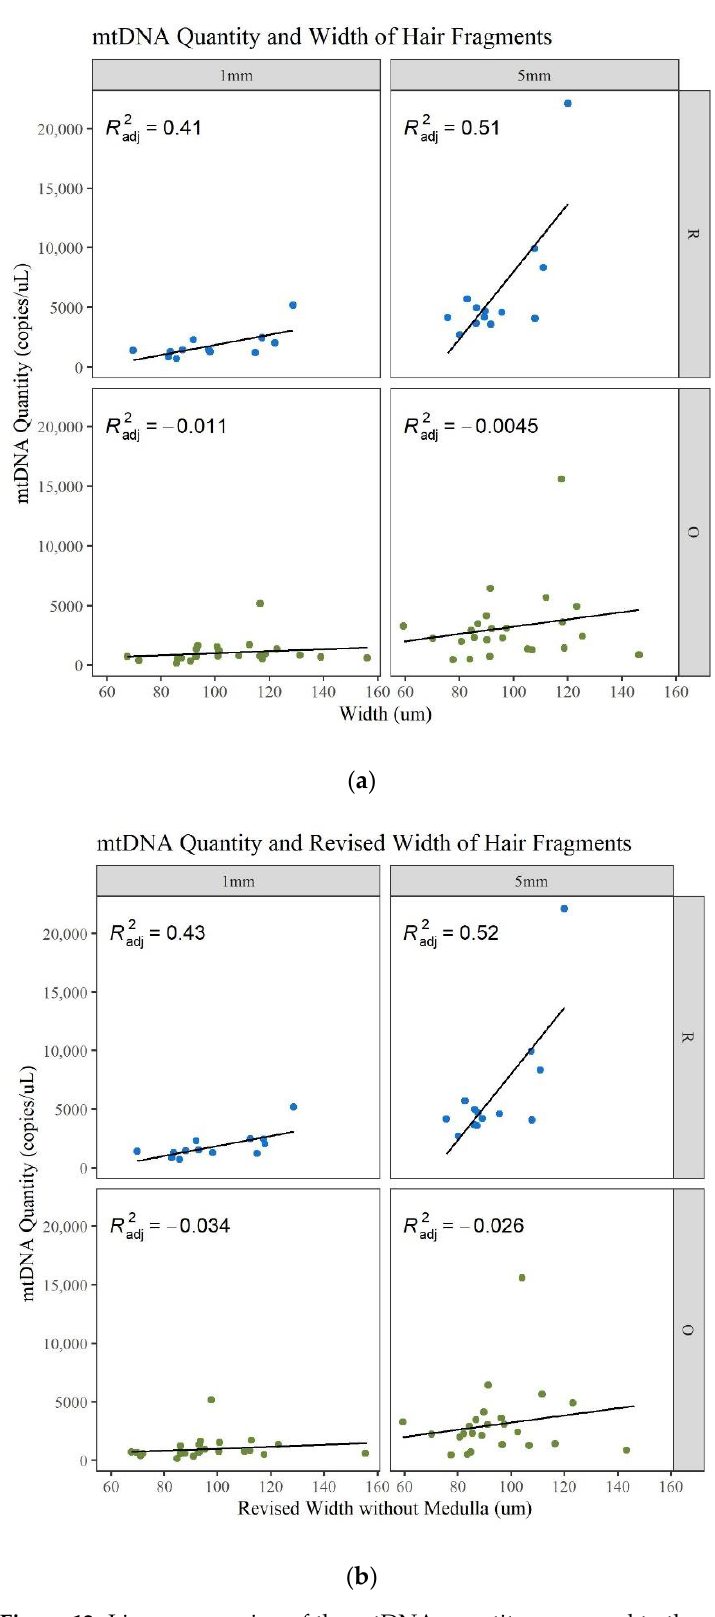
Figure 12. Linear regression of the mtDNA quantity compared to the width of the hair. ( a ) Width including the medulla. ( b ) Width excluding the medulla.